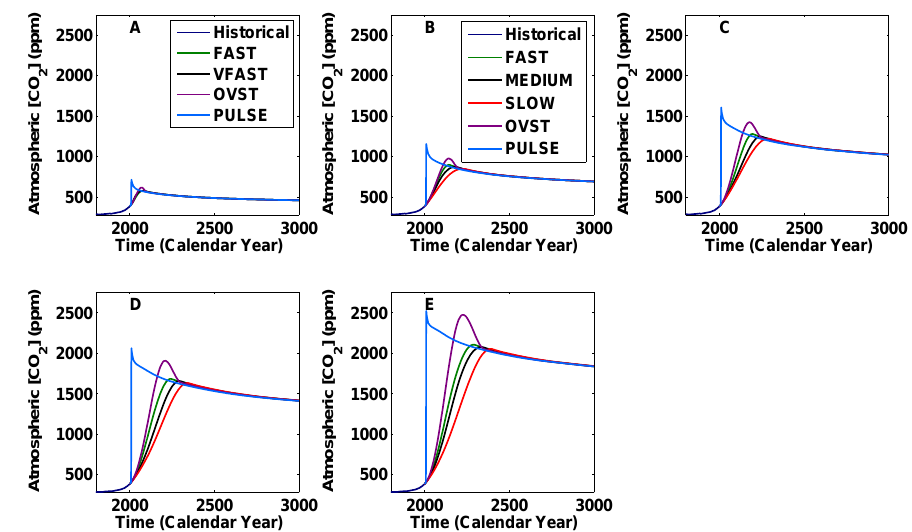
Figure 2. Atmospheric CO 2 concentration for the 1275–5275GtC scenarios. (a) 1275GtC scenarios, (b) 2275GtC scenarios, (c) 3275GtC scenarios, (d) 4275GtC scenarios, and (e) 5275GtC scenarios. Note: legend for (b) also applies to (c–e) .